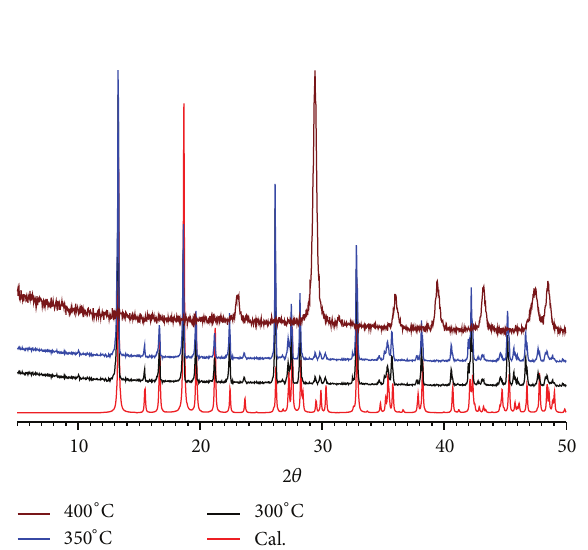
Figure 6: Powder XRD patterns of the complex at various temper-